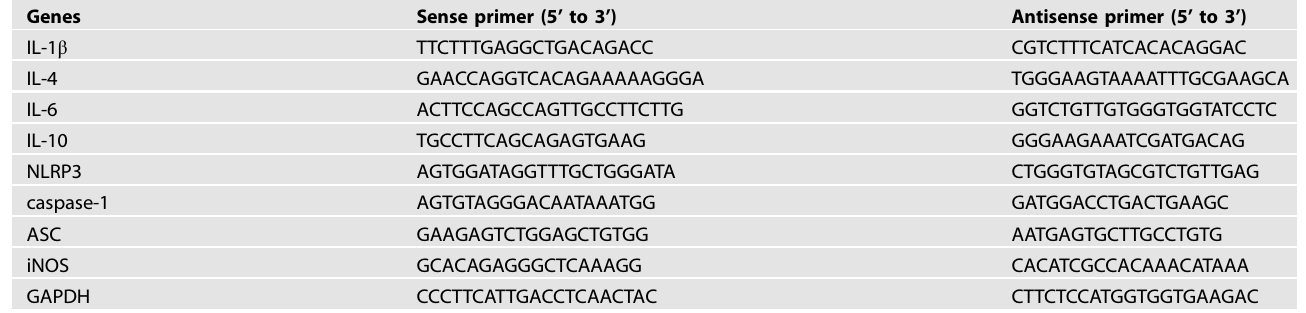
Table 1. Oligonucleotide primers used for mRNA real-time